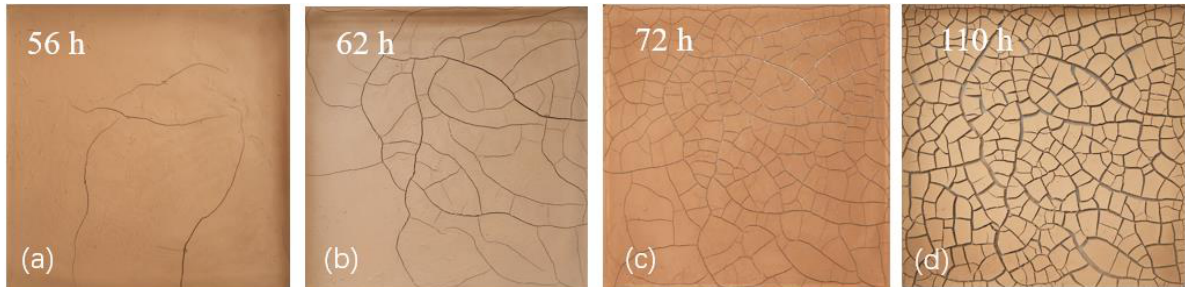
Figure 6. Development characteristics of soil fissure with root system. ( a ) Cracks appear; ( b ) Main fissure formation; ( c ) Secondary fissure formation; ( d ) Fissure extension.